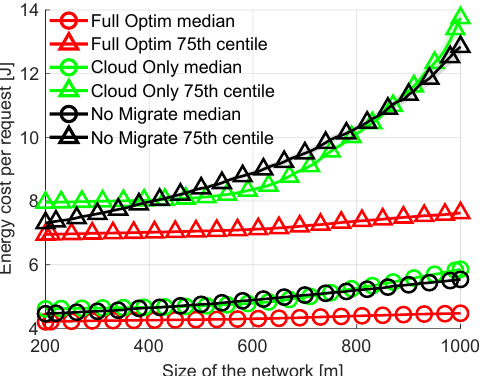
Figure 5. Comparison of energy consumption per request with varied size of area covered by the